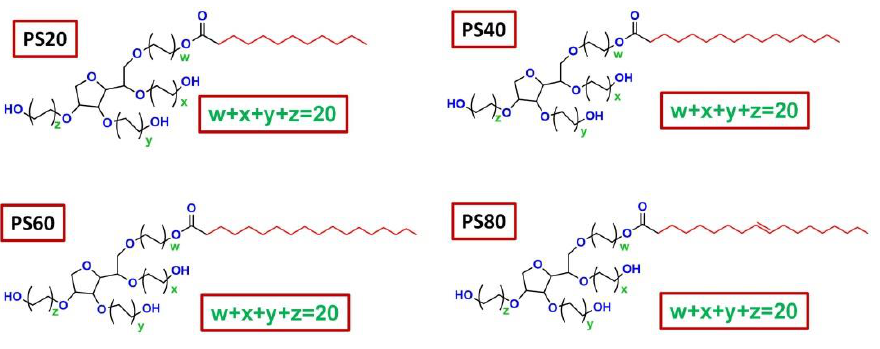
Figure 2. Chemical structures of various polysorbates.